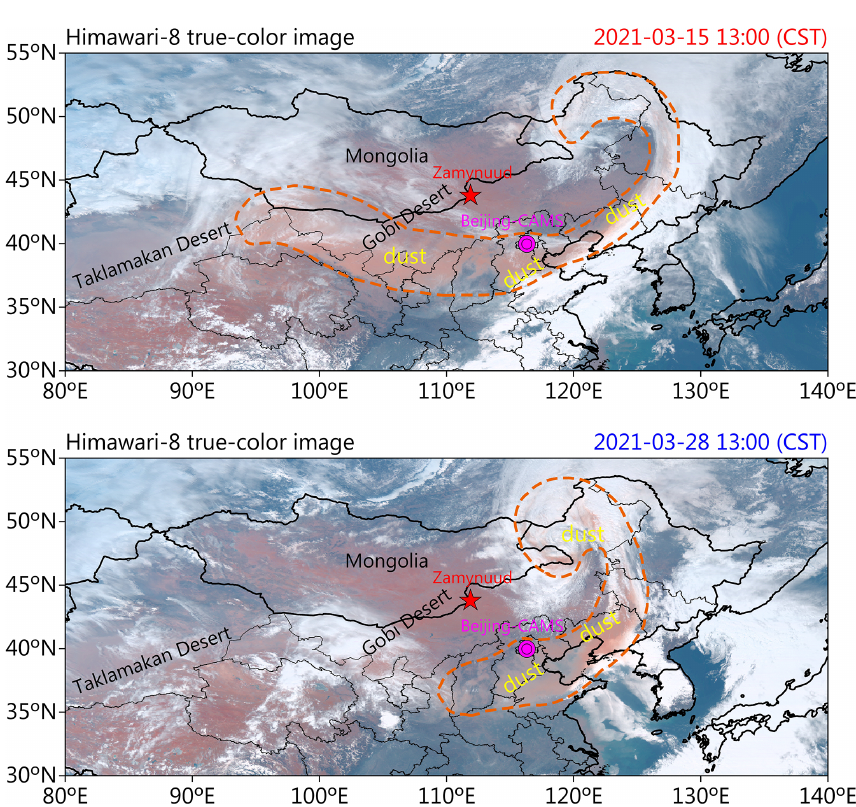
Figure 1. True-color image of dust plumes above the Earth’s surface captured by the Himawari-8 at 13:00CST (China standard time) of 15 March (top) and 28 March 2021 (bottom). The location of the AD-Net lidar site named “Zamynuud” (43.72 ◦ N, 111.90 ◦ E; 962m) and the sun photometer site named “Beijing-CAMS” (39.93 ◦ N, 116.32 ◦ E; 106m) are marked on the map with a red star and a magenta circle, respectively. Orange dashed lines outline the area covered by the dust